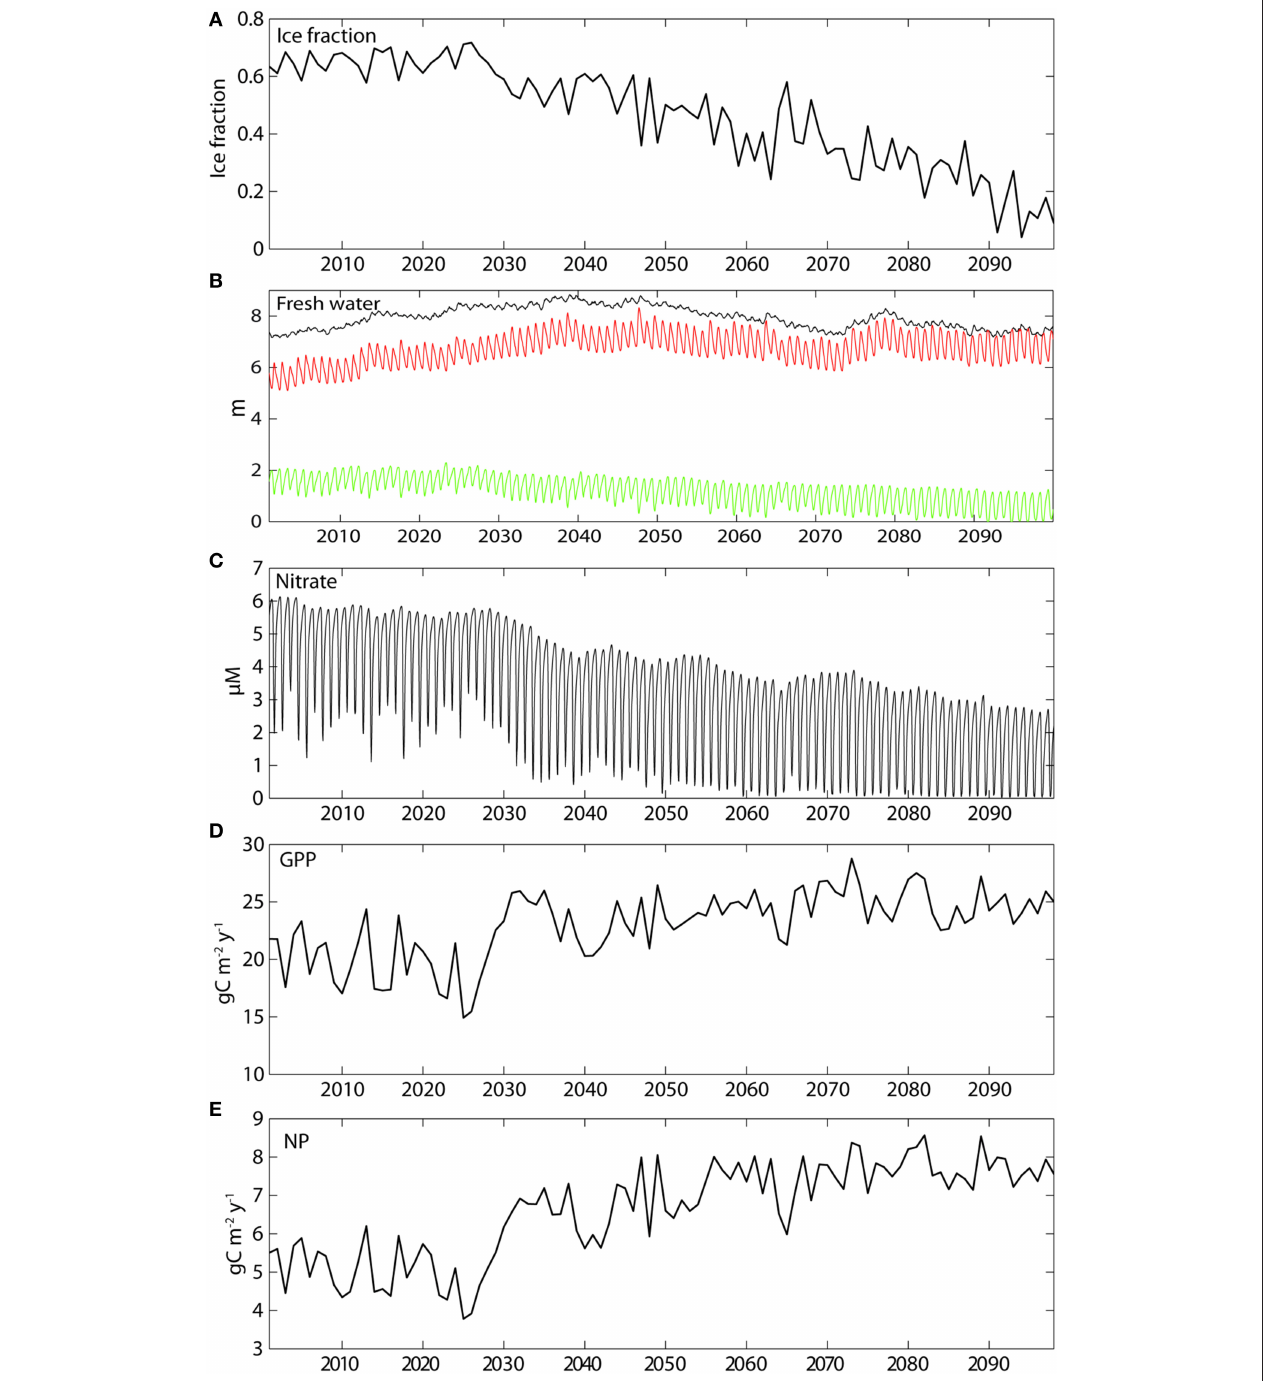
FIGURE 11 | Mean annual simulated ice concentration for April (%, A), the total (black), liquid (red), and ice (green) bound freshwater heights in the upper 100m of the water column using a reference value of salinity of 35 (B), the nitrate surface concentrations (C), and the annual gross primary (D) and new primary (E) productions (g C m − 2 y − 1 ) in the Arctic Ocean basins throughout this century (A1B).